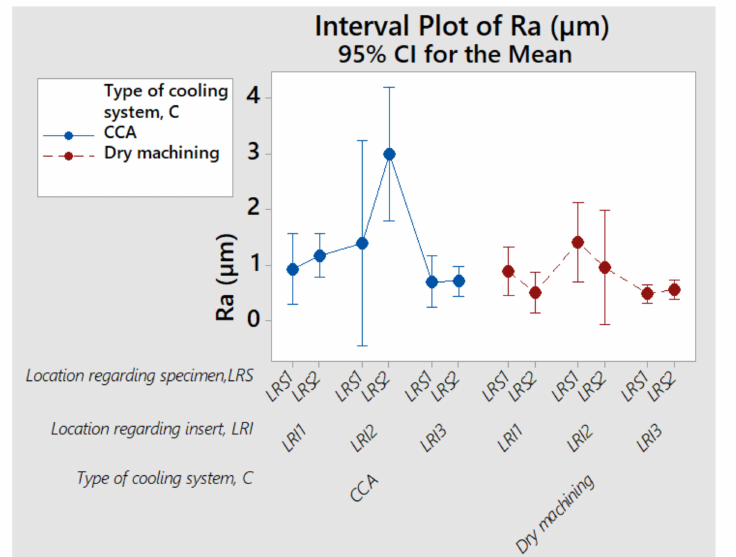
Figure 5. Mg-Al-Mg test. (a) Multiple interval plot with groups: type of cooling system type, C ; Location Regarding Insert, LRI ; Location Regarding Specimen, LRS